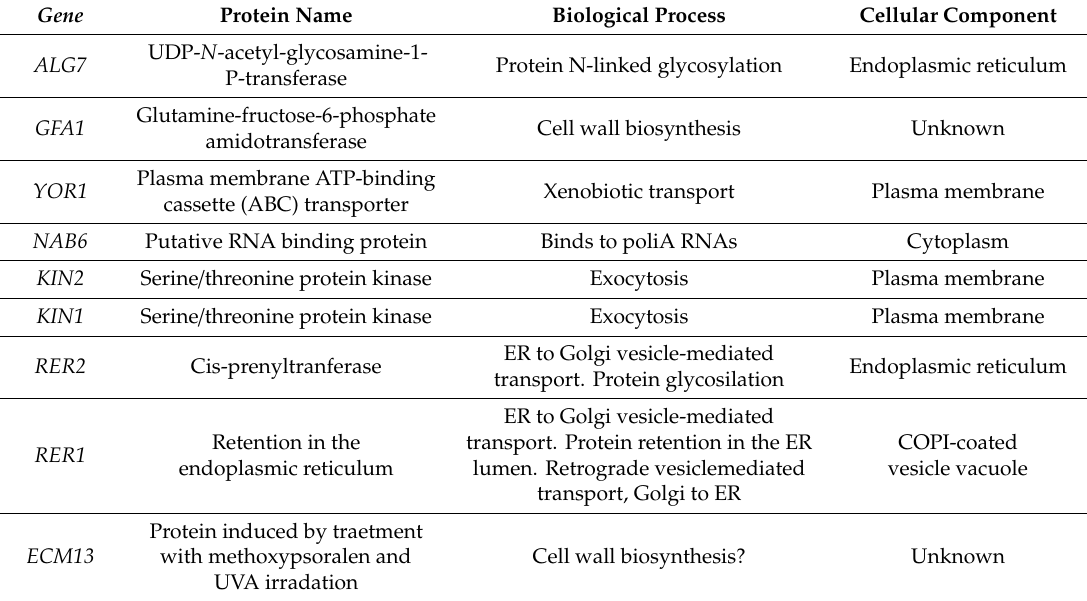
Table 1. General and specific suppressors and the cellular process where they